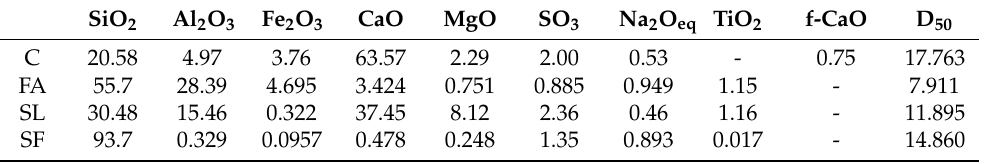
Table 1. The chemical compositions of raw materials (calculated by mass fraction %).